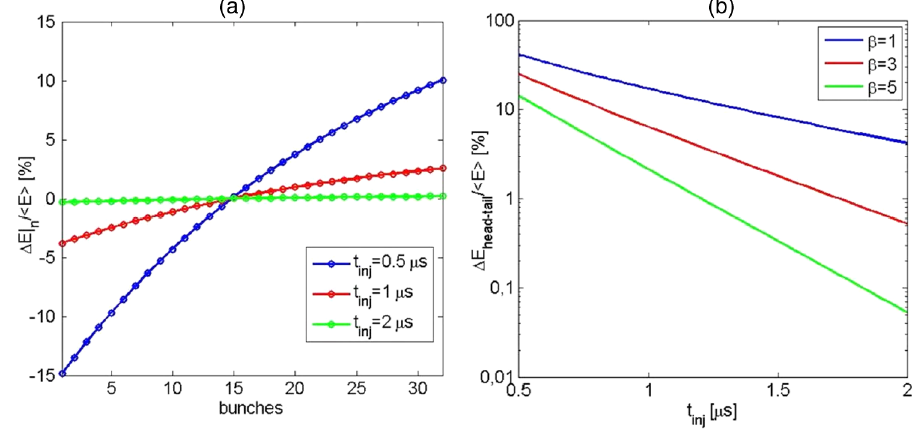
FIG. 36. (a) Multibunch energy spreads in the bunch train for different injection times, assuming a uniform input power profile; (b) full multibunch energy spread in the train as a function of the injection